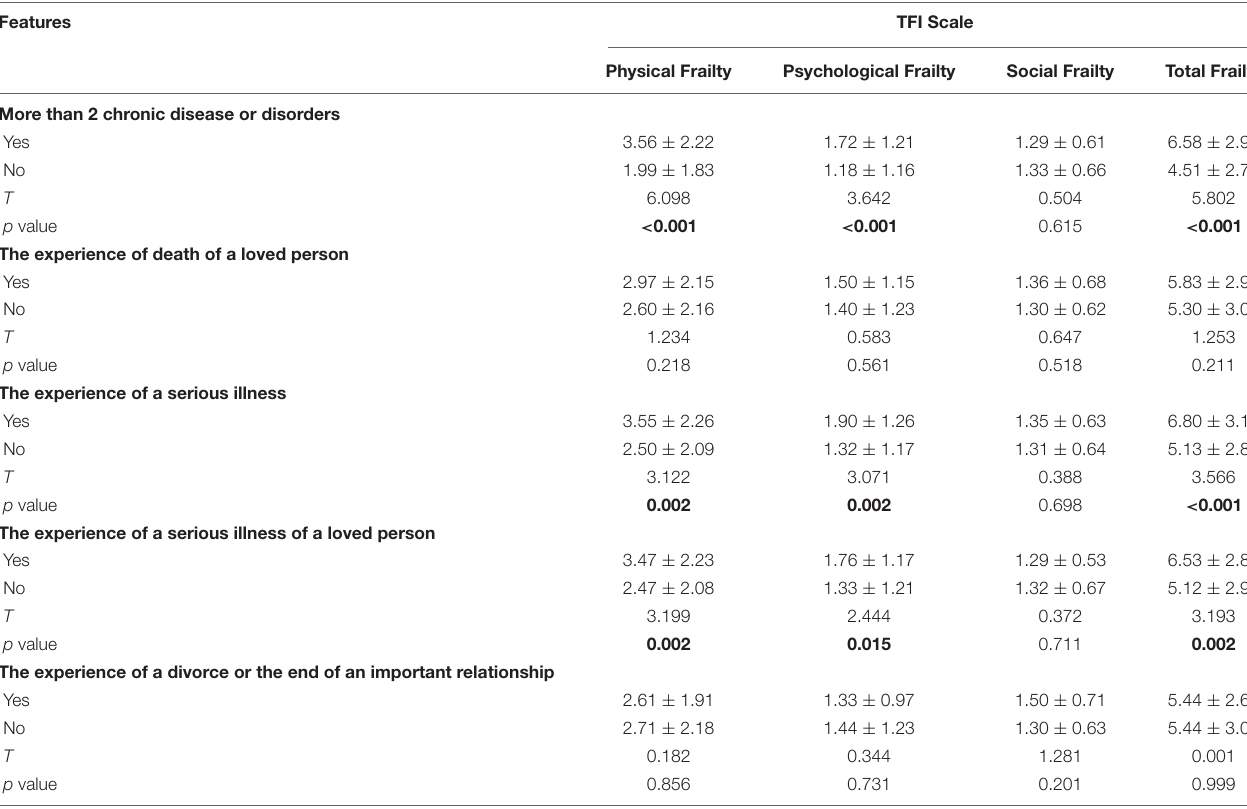
TABLE 3 | Differences of frailty (TFI) among groups of chronic diseases and traumatic events exposure.